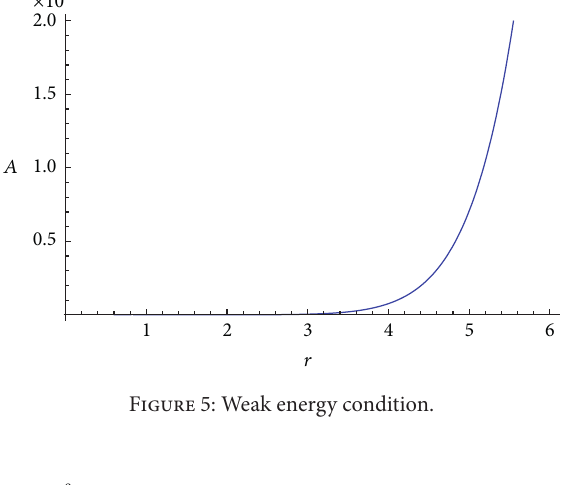
Figure 5: Weak energy condition.